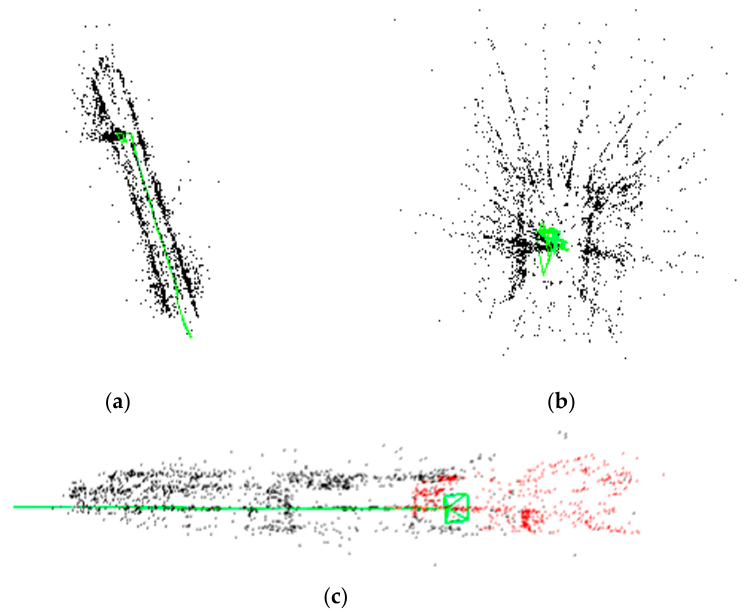
Figure 8. Three-dimensional sparse reconstruction. ( a ) Top view of the corridor; ( b ) face view of the corridor; ( c ) side view of the